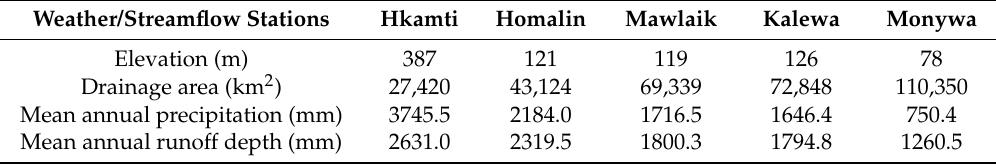
Figure 2. Mean monthly: ( a ) Air temperature; ( b ) precipitation; and ( c ) runoff at main weather and streamflow stations in the Chindwin River basin. Table 1. Basic information of main weather/streamflow stations in the Chindwin River basin.